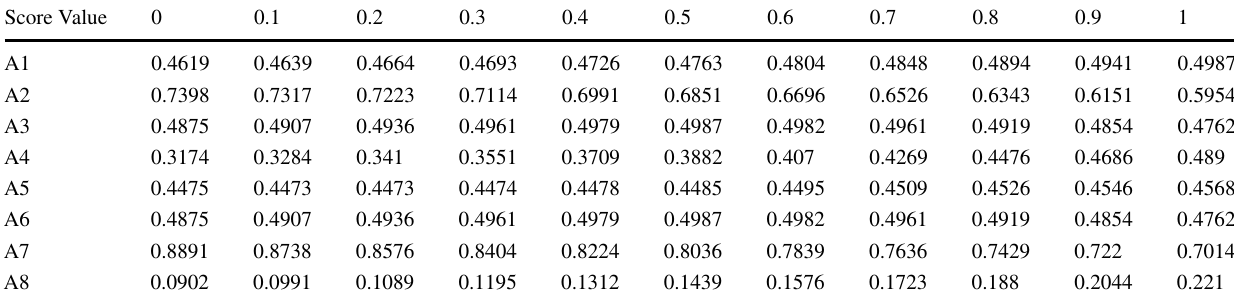
Table 12 Sensitive analysis with